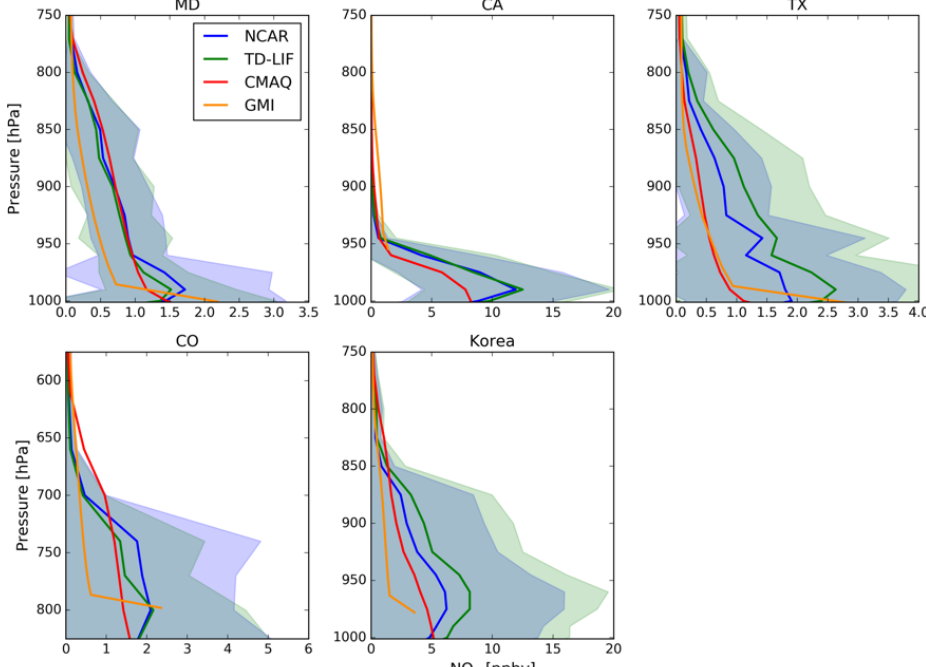
Figure 2. Mean early afternoon NO 2 profiles, both observed and modeled, for the DISCOVER-AQ and KORUS-AQ campaigns. Colored lines represent the average for airborne in situ profiles from NCAR (blue) and TD-LIF (green) instruments compared with simulated profiles from the GMI global model (orange) and the CMAQ (DISCOVER-AQ) or WRF-Chem (KORUS-AQ) regional models (red). The standard deviations of airborne profiles are indicated as shaded areas for NCAR (lavender) and TD-LIF (green) instruments. The blue–gray color represents the overlap of the